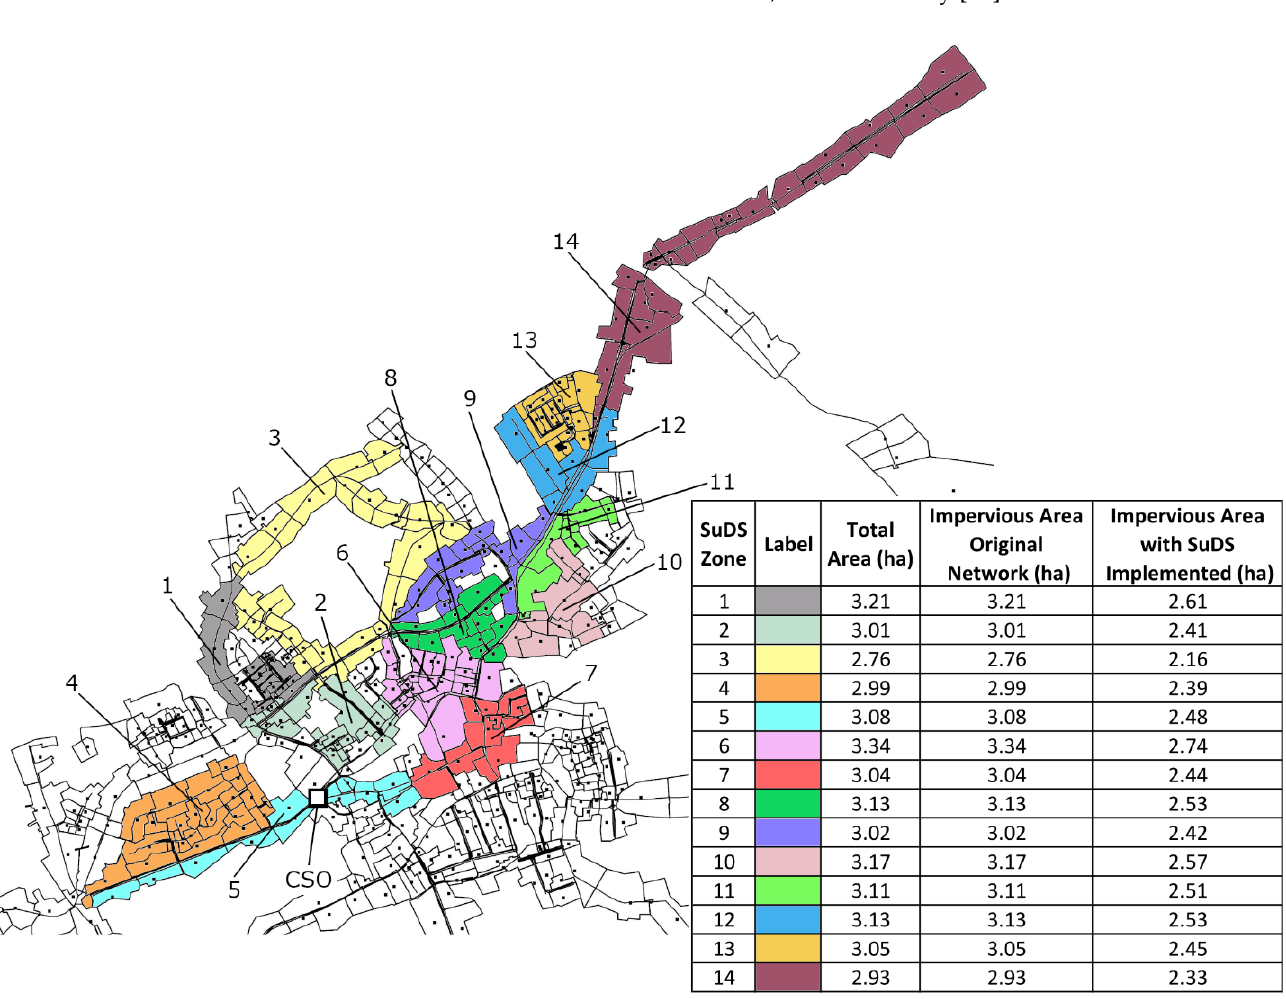
Figure 1. SuDS zones selected within the SWMM Arendonk sewer network model (0.6 hectares of impervious area were converted to pervious area in each SuDS zone).